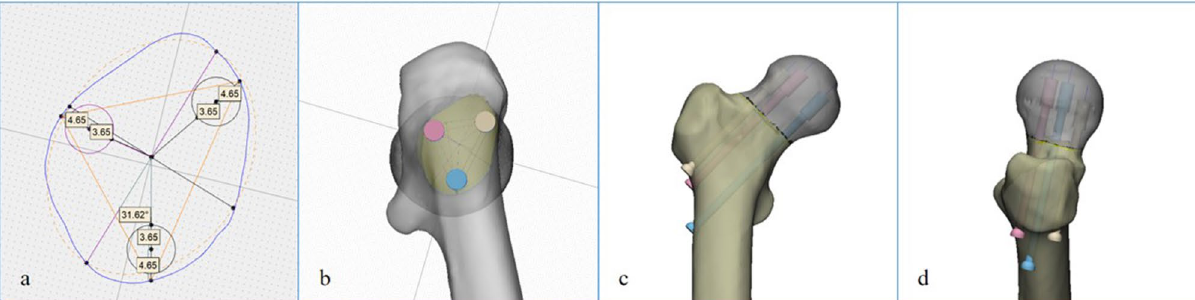
Figure 7. According to the oblique triangle configuration, the position of the three screws on the cross-section of the femoral neck isthmus by the 3-Matic software. ( a ) The blue line was the contour of the femoral neck isthmus, and the yellow dashed line was the fitted ellipse of the femoral neck isthmus. ( b ) The configuration of the screws according to the cross-section of the FNI. ( c ) the OTC in anteroposterior view, ( d ) the OTC in lateral